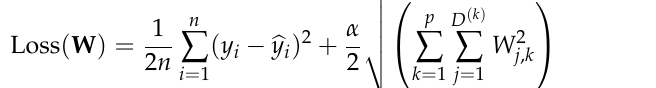
Table 4. Common activation functions.